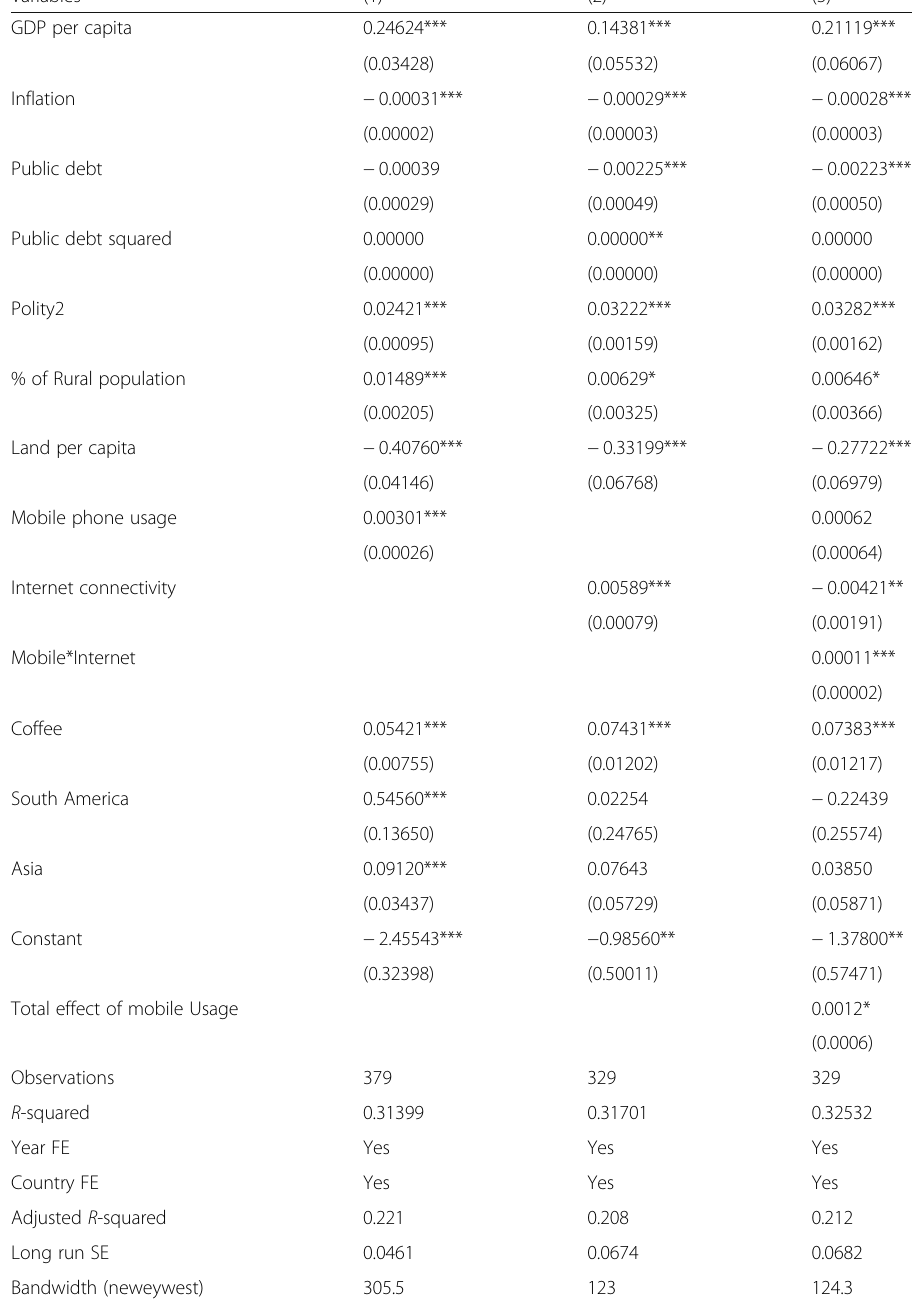
Table 4 Determinants of relative price margin